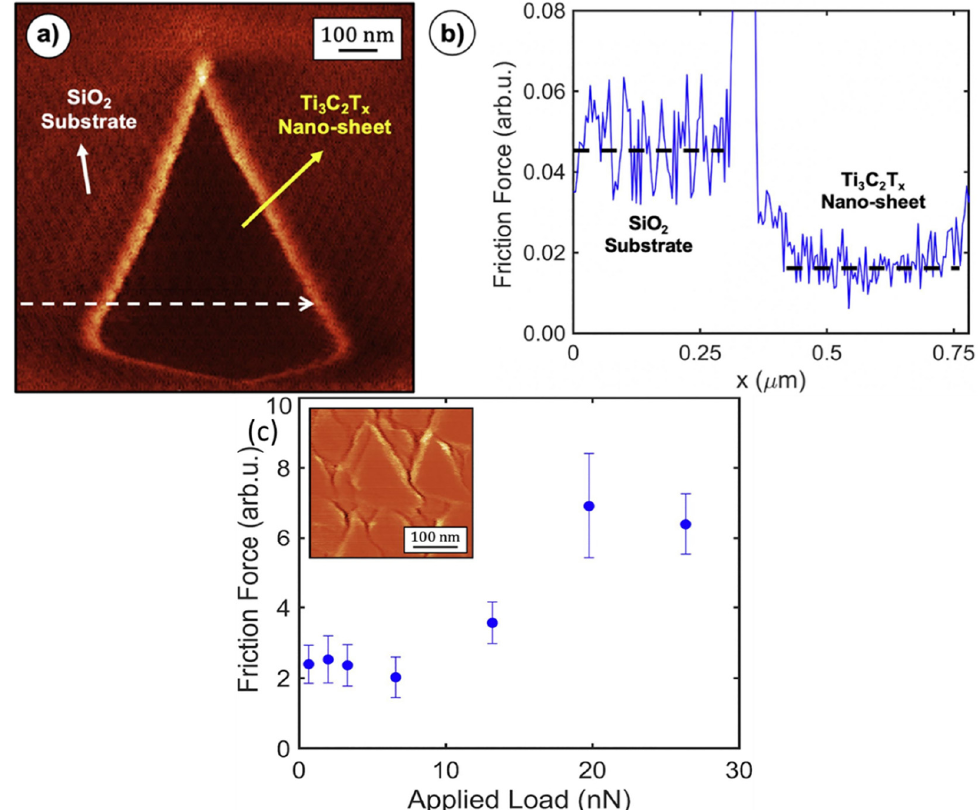
Figure 8. ( a ) Friction map captured on few thin Ti 3 C 2 Tx nanosheet resting on a SiO 2 substrate. ( b ) Line profile taken from friction map of ( a ) following the white arrow’s dashed line. ( c ) Mean friction calculated as a function of the applied load and measured on several layers of Ti 3 C 2 Tx nano-sheet-based film. (Reprinted from Applied Surface Science, 535, A. Rodriguez, M.S. Jaman, O. Acikgoz, B. Wang, J. Yu, P. G. Grützmacher, A. Rosenkranz, and M.Z. Baykara, The potential of Ti 3 C 2 TX nano-sheets (MXenes) for nanoscale solid lubrication revealed by friction force microscopy, 147664, Copyright (2021), with permission from